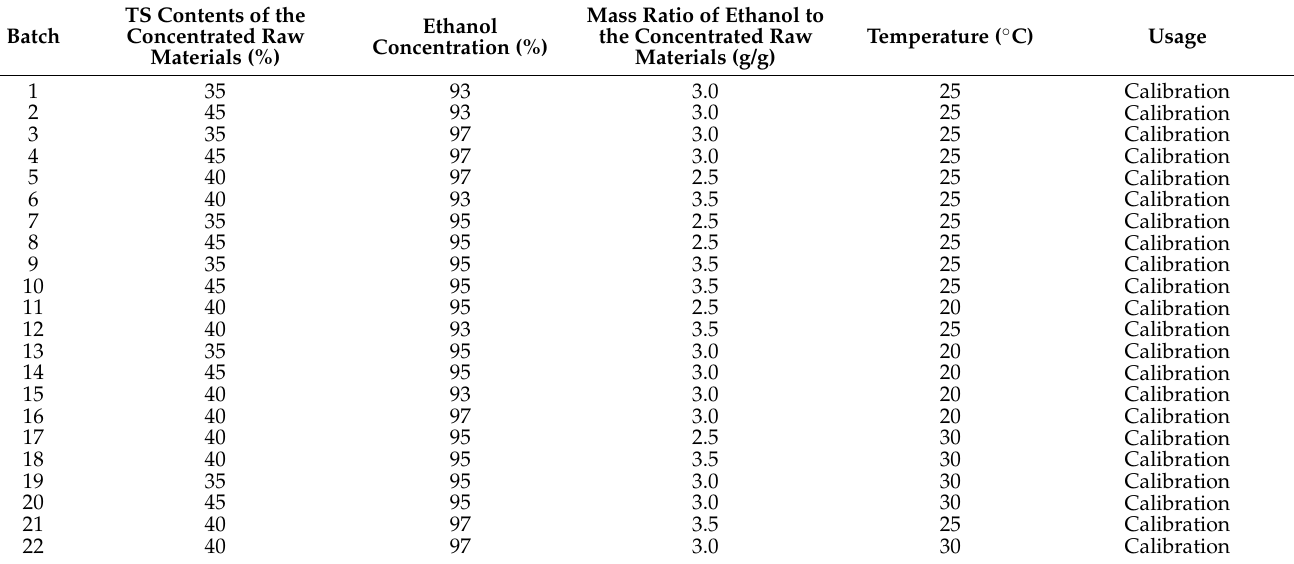
Table 1. Conditions for the alcohol precipitation experiments according to the Box–Behnken